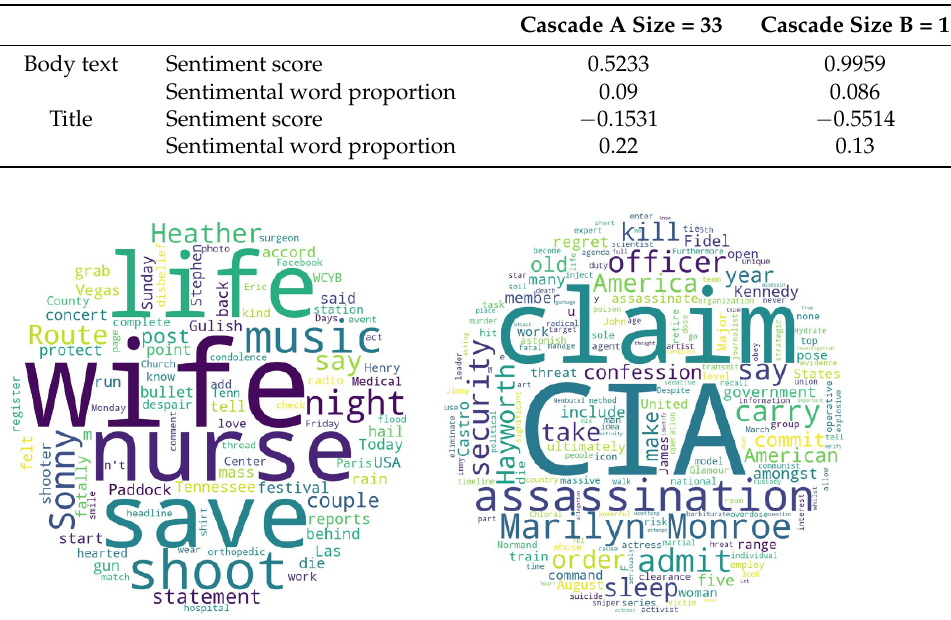
Table 7. News statistics of two source tweets having large and small cascade sizes.